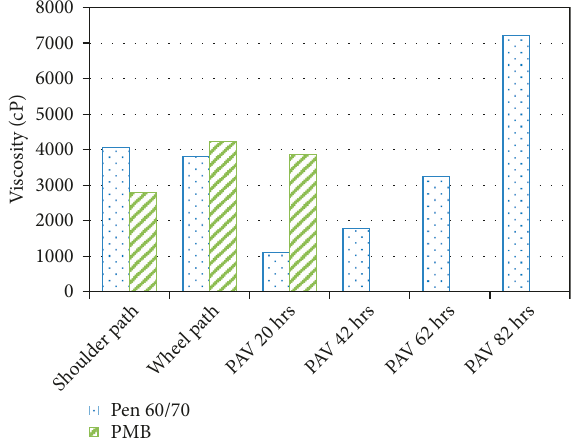
Figure 5: Comparison of PAV-aged binders with binders re- covered from 5-year old pavement (after Sirin et al.